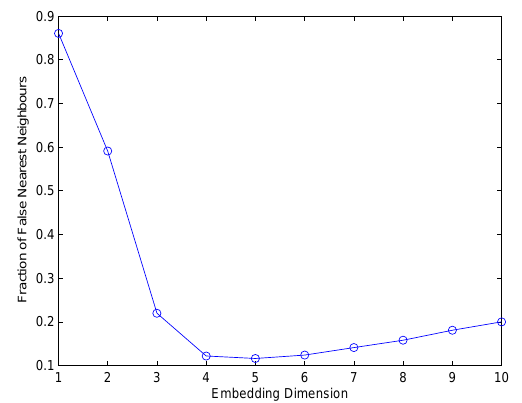
Figure 5. The delay representation of the phase space reconstruc- tion of the detrended